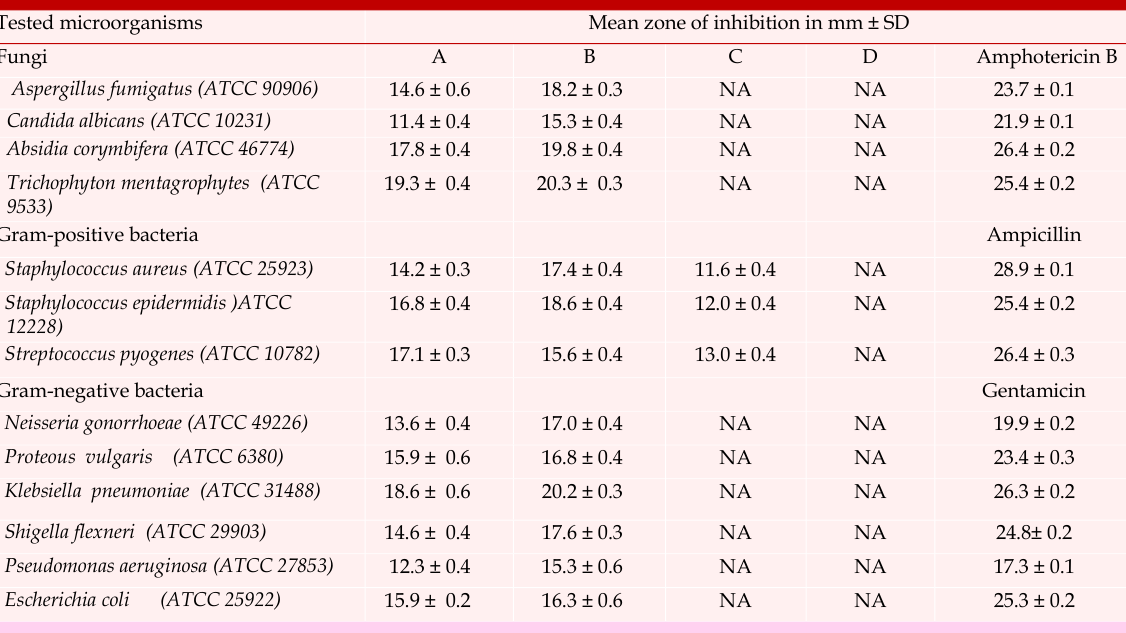
Mean zone of inhibition beyond 6 mm well diameter using (20 mg/mL) concentration of A-D Tested microorganisms Mean zone of inhibition in mm ±